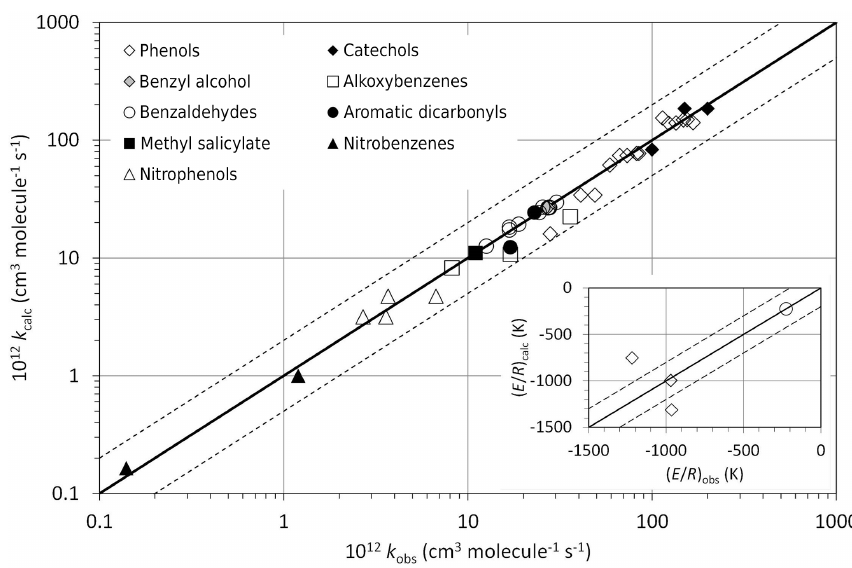
Figure 2. A log–log correlation of k calc and k obs at 298K for oxygenated aromatic compounds. The broken lines show the factor of 2 range. The inset plot shows a correlation of the temperature coefficients ( E/R) calc and ( E/R) obs for phenol, cresols and benzaldehyde (note that the data points for o - and p -cresol are coincident at ( E/R) obs = − 970K, ( E/R) calc = − 996K). The broken lines show the ± 200K range.